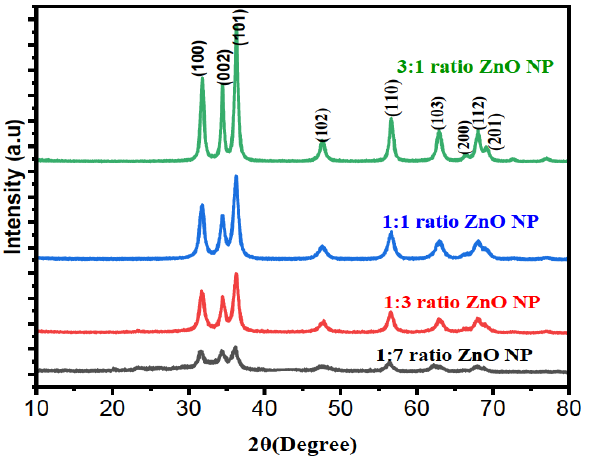
Figure 5: XRD diffraction patterns of synthesized ZnO NPs.